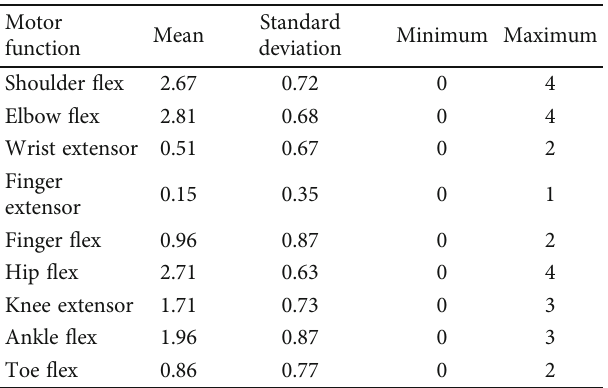
Figure 1: Data gathering process of the simulation. Table 1: Motricity index